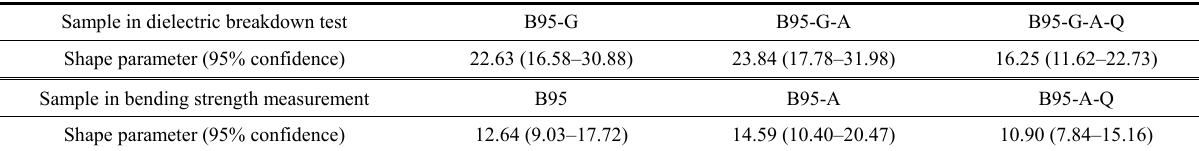
Table 2 Shape parameters of the Weibull distribution fitting in the dielectric breakdown test and the bending strength measurement of B95